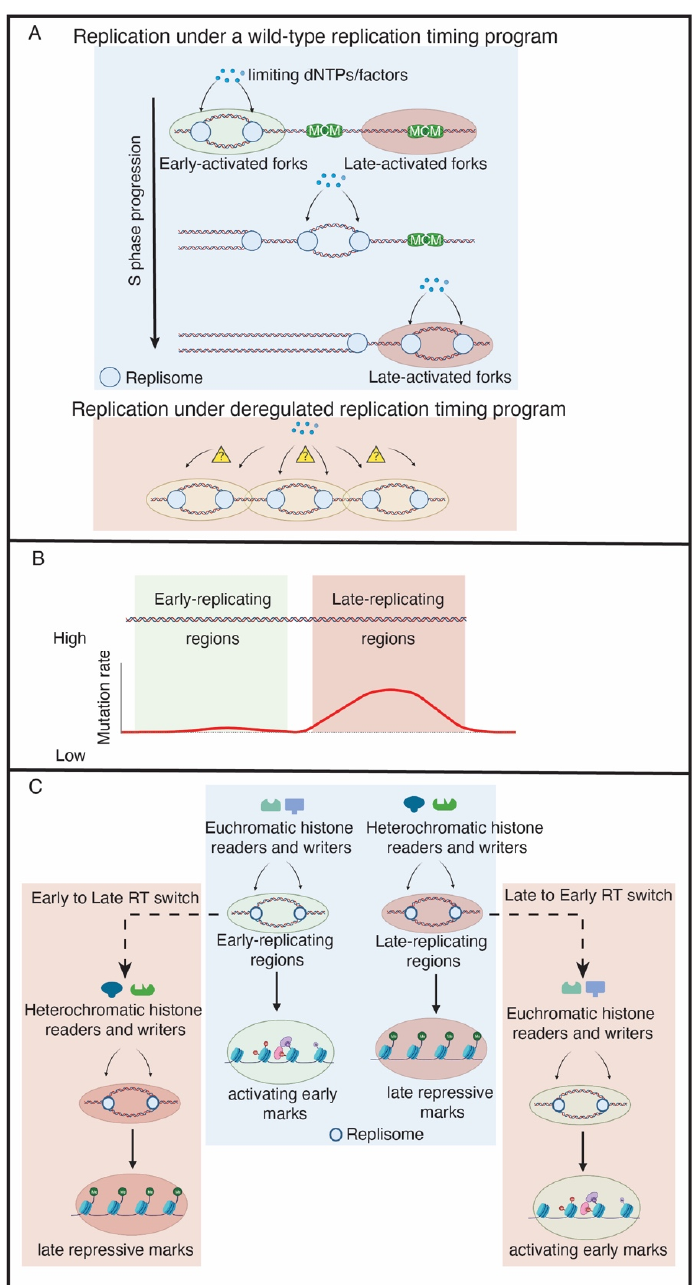
Figure 1. The functions of replication timing. ( A ) The replication timing program maintains a supply–demand equilibrium of limiting replication factors, which could be histones, replisome proteins or dNTPs. In a de-regulated replication timing program, an excess of origins may become activated, resulting in the pool of limiting replication factors to be depleted and DNA damage to occur. ( B ) Late-replicating regions have a higher mutation rate than early-replicating regions. ( C ) The replication timing program maintains the epigenetic landscape. In the wild-type example (blue box), replication timing preserves the epigenetic landscape. This is achieved by allowing euchromatic and heterochromatic histone readers and writers to be properly recruited to replication forks within early and late-replicating regions, respectively, during S phase. The pink boxes indicate de-regulated replication timing. In this example, a region switches from early to late replicating (E to L Switch) or late to early replicating (L to E switch). Consequently, the wrong histone readers and writers are targeted to those regions. This results in the epigenetic landscape changing upon replication timing disruption.